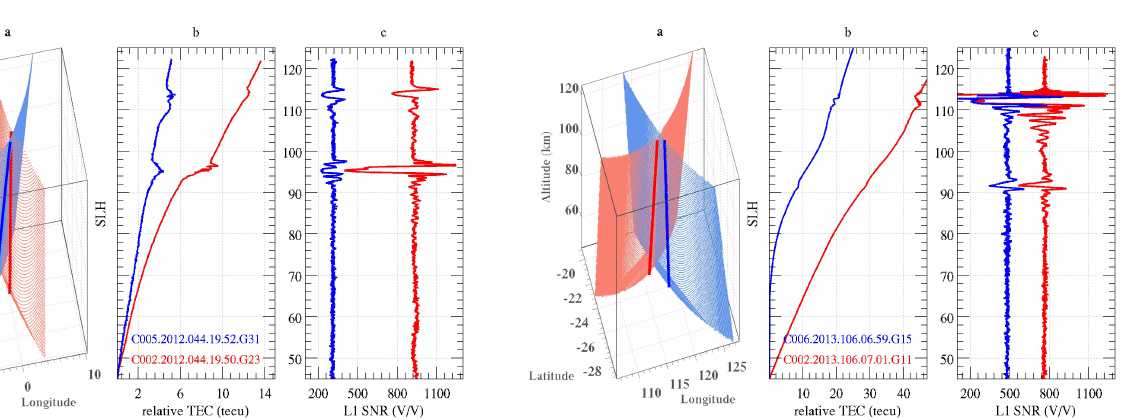
Figure 3. Two colocated RO events, which present two peaks in either relative TEC or L1 SNR versus straight line height, observed by different COSMIC LEO satellites at the same time on day 44 of 2012: (a) occultation plane and corresponding tangent points; (b) relative slant TEC versus straight line height (SLH); (c) L1 SNR versus straight line height. Blue and red represent two different RO events.